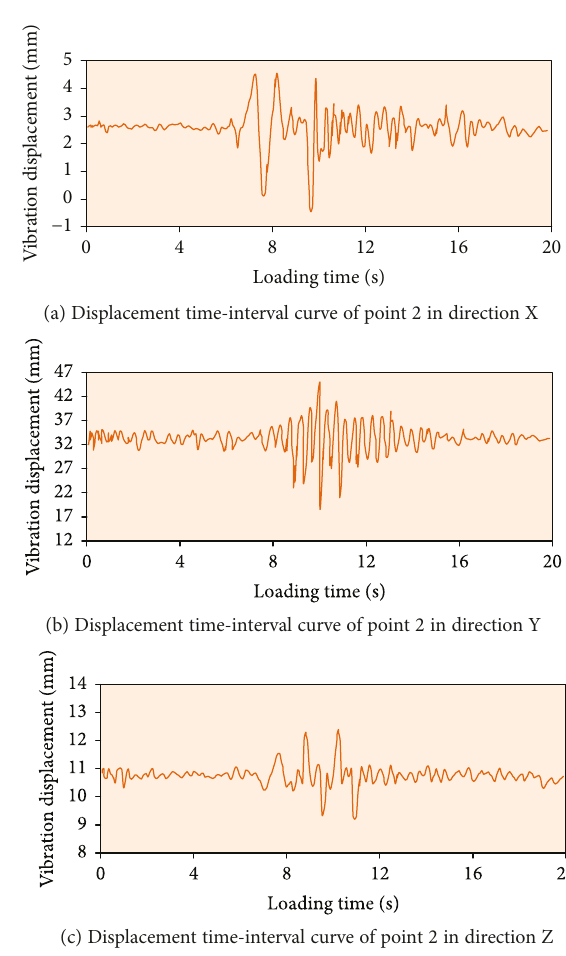
Figure 13: Displacement time-interval curves of point 2 in directions X, Y, and Z.